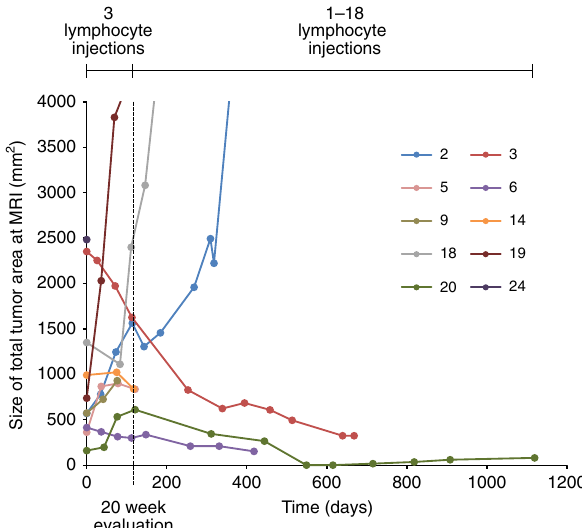
Fig. 5 Treatment responses in 10 patients with relapsed GBM. All patients shown had at least three injections of cytotoxic lymphocytes. Shown is the size of the contrast-enhancing tumor on MRI. In general, the MRI measurements were obtained in connection with the in-hospital treatment